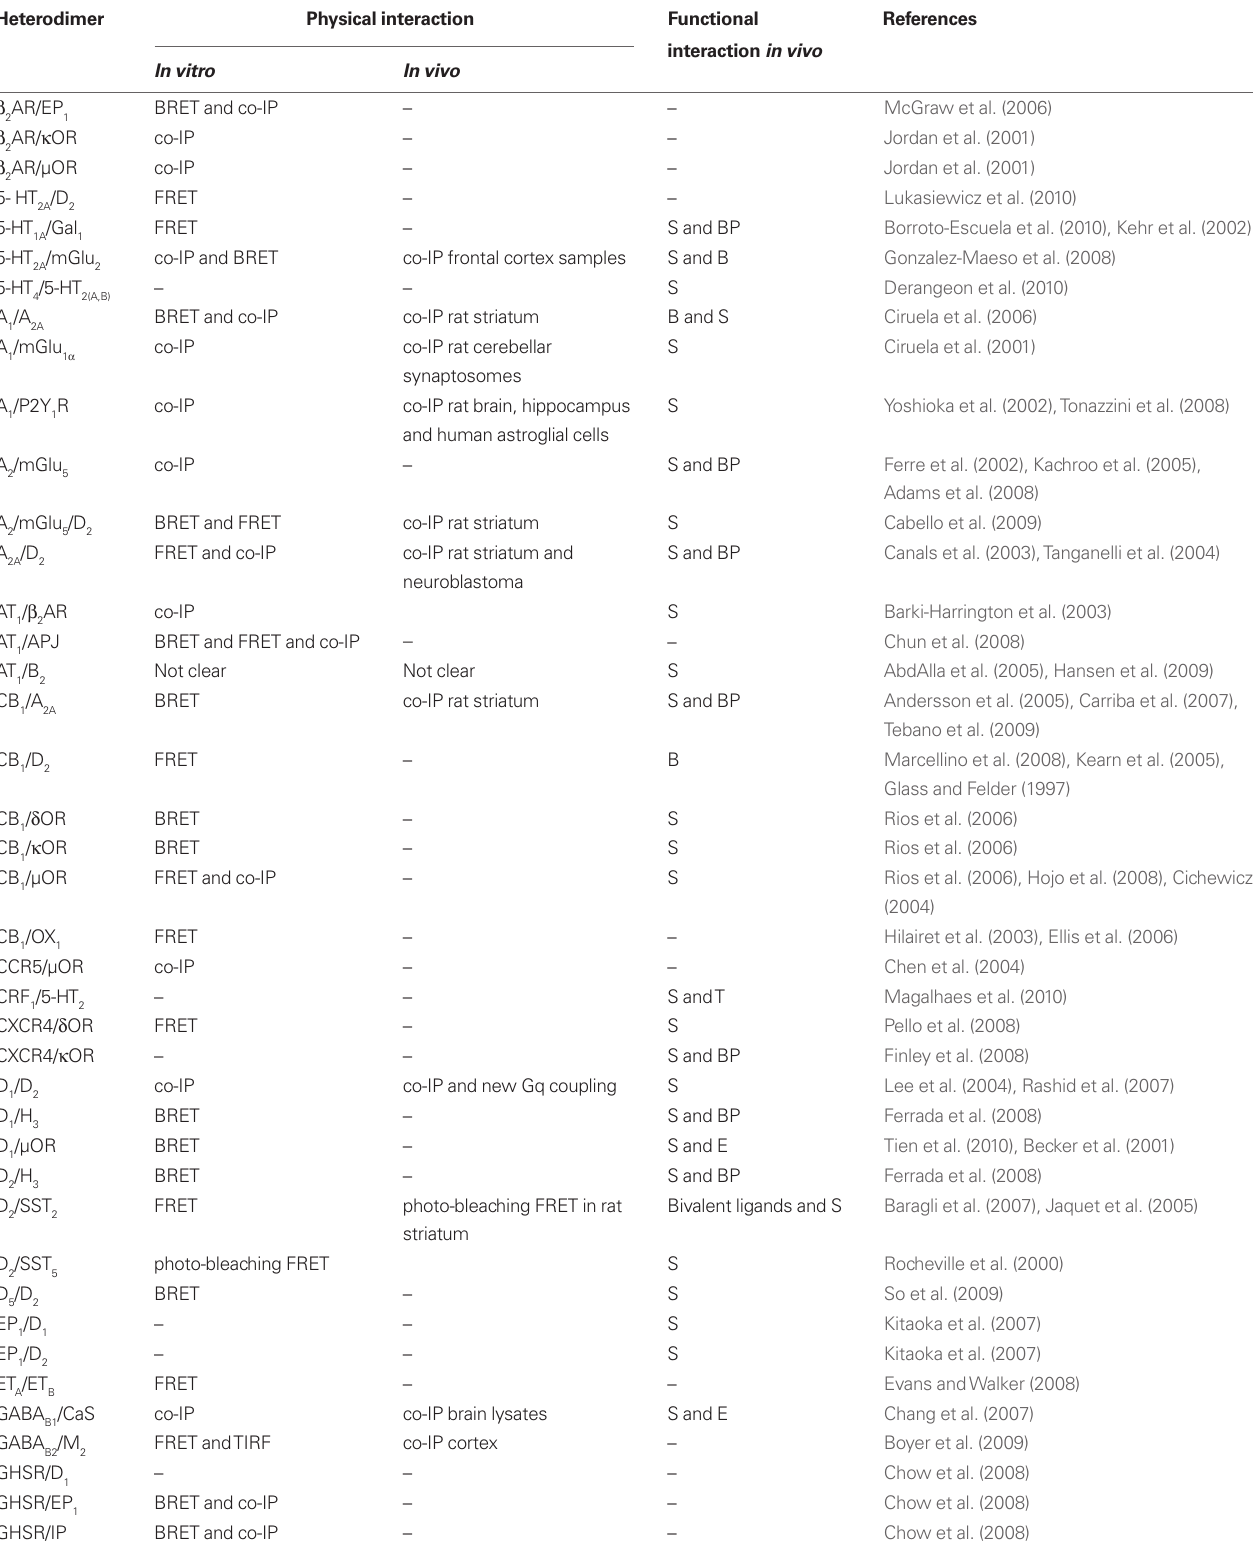
Table 1 | Non-exhaustive list of GPCR heteromers in the neuro-endocrine system.